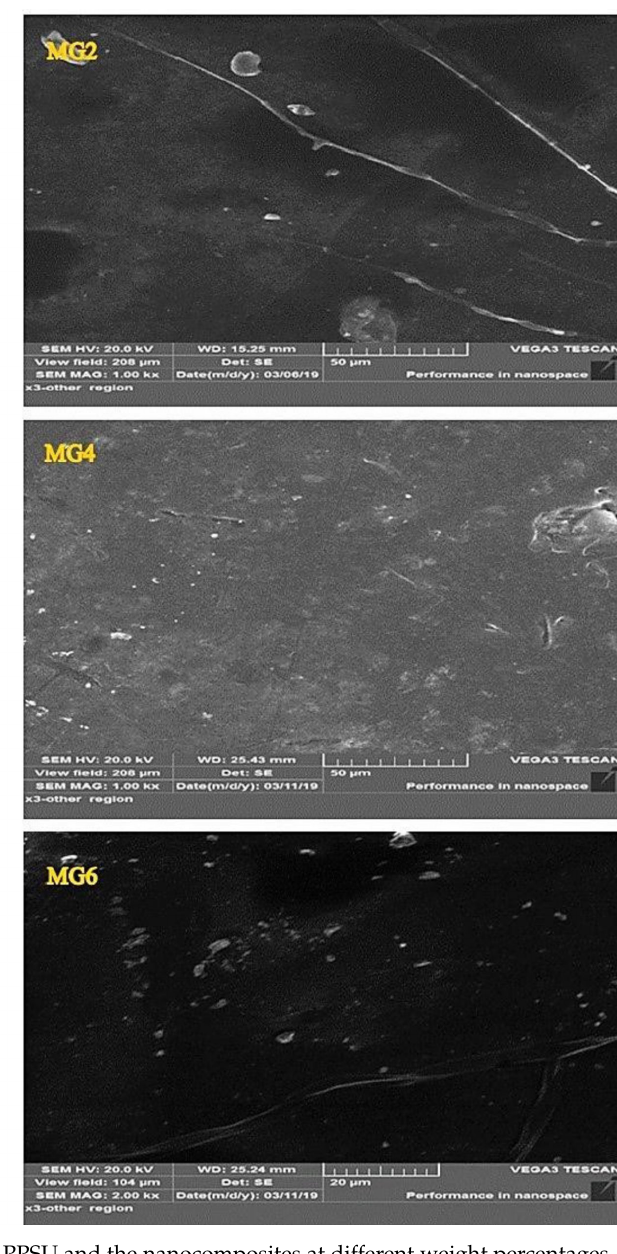
Figure 1. The FESEM images of the cross-sections of pristine PPSU and the nanocomposites at different weight percentages 0.05, 0.1, 0.15, 0.2, and 0.25 wt.%